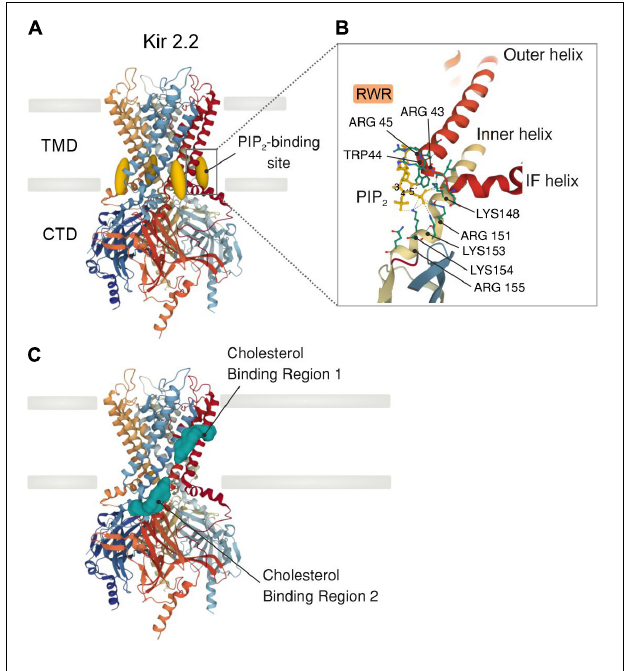
FIGURE 2 | X-ray crystal structure of a Kir2.2 channel with PIP 2 or cholesterol bound. (A) Side view of a model of a Kir2.2 tetramer consisting of a transmembrane domain (TMD), which comprises the potassium-selective pore, and a large cytosolic (CTD) domain (PDB ID: 3SPI). PIP 2 molecules (dark yellow) bind at the interface between the TMD and the CTD. (B) Detailed illustration showing the PIP 2 -binding site in a similar orientation as outlined in A. The primary amino acid residues bound (dashed lines) to PIP 2 are highlighted. All side chains are shown as solid lines. (C) Side view of a Kir2.2 channel model illustrating the two distinct cholesterol binding regions (green): one residing in the center of the TMD and the other at the interface between the TMD and the CTD.